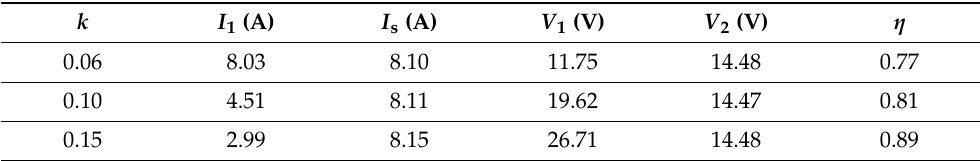
Table 1. Electrical quantities in the equivalent circuit for different values of the coupling factor k